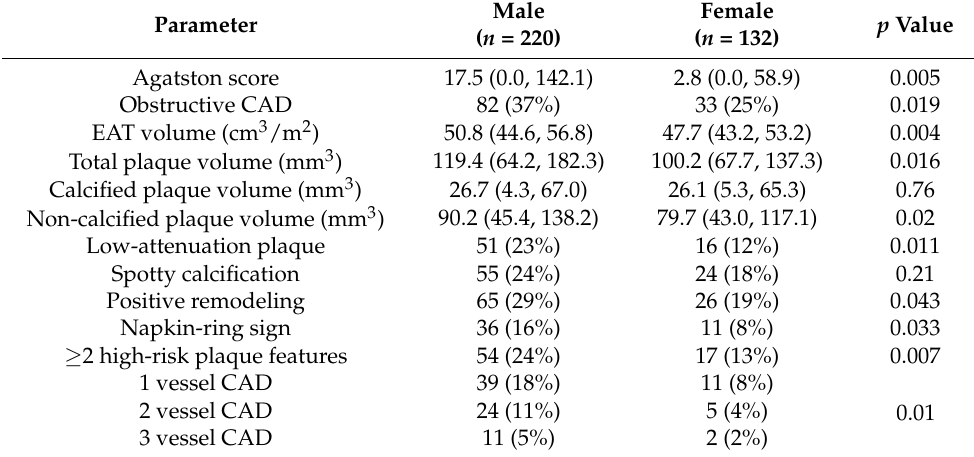
Table 2. Findings of quantitative analysis of coronary CT markers in men and